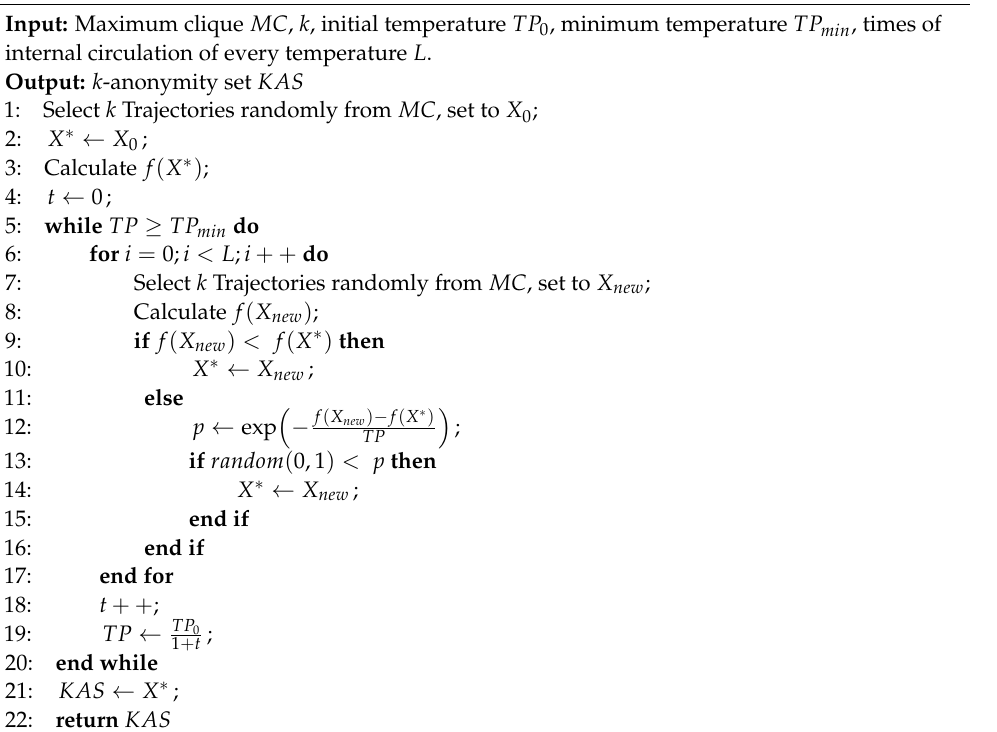
Algorithm 3. Search for k -anonymity set